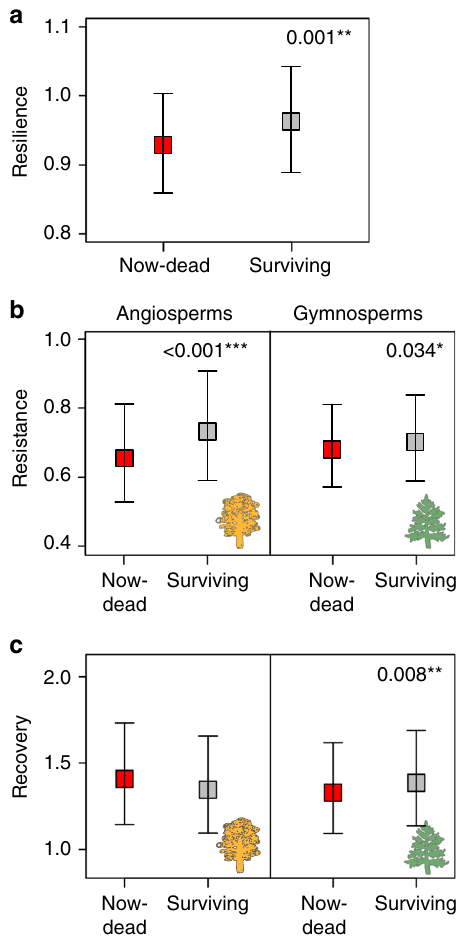
Fig. 2 Differences in resilience, resistance and recovery between now- dead and surviving trees. a Differences in resilience between now-dead and surviving trees. Differences in b resistance and c recovery between now-dead and surviving trees as a function of the taxonomic group (angiosperms vs. gymnosperms). The data are presented as model- adjusted, back-transformed least-square means ± 95% con fi dence intervals (Table 1). Resilience, resistance and recovery indices were computed from tree-ring width (TRW) series of surviving (grey squares) and now-dead (red squares) trees. Asterisks indicate signi fi cant pairwise differences in least square means between now-dead and surviving trees ( t or χ 2 test in LMM: * P < 0.05; ** P < 0.01; *** P < 0.001). Panels are separated by taxonomic group only when differences between angiosperms and gymnosperms are signi fi cant (Table 1). Source data are available in Digital. CSIC repository